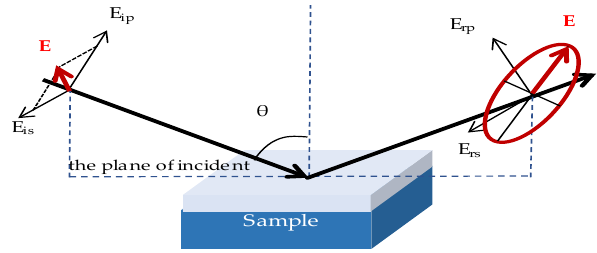
Figure 1. Schematic diagram of the principle of spectroscopic ellipsometry.